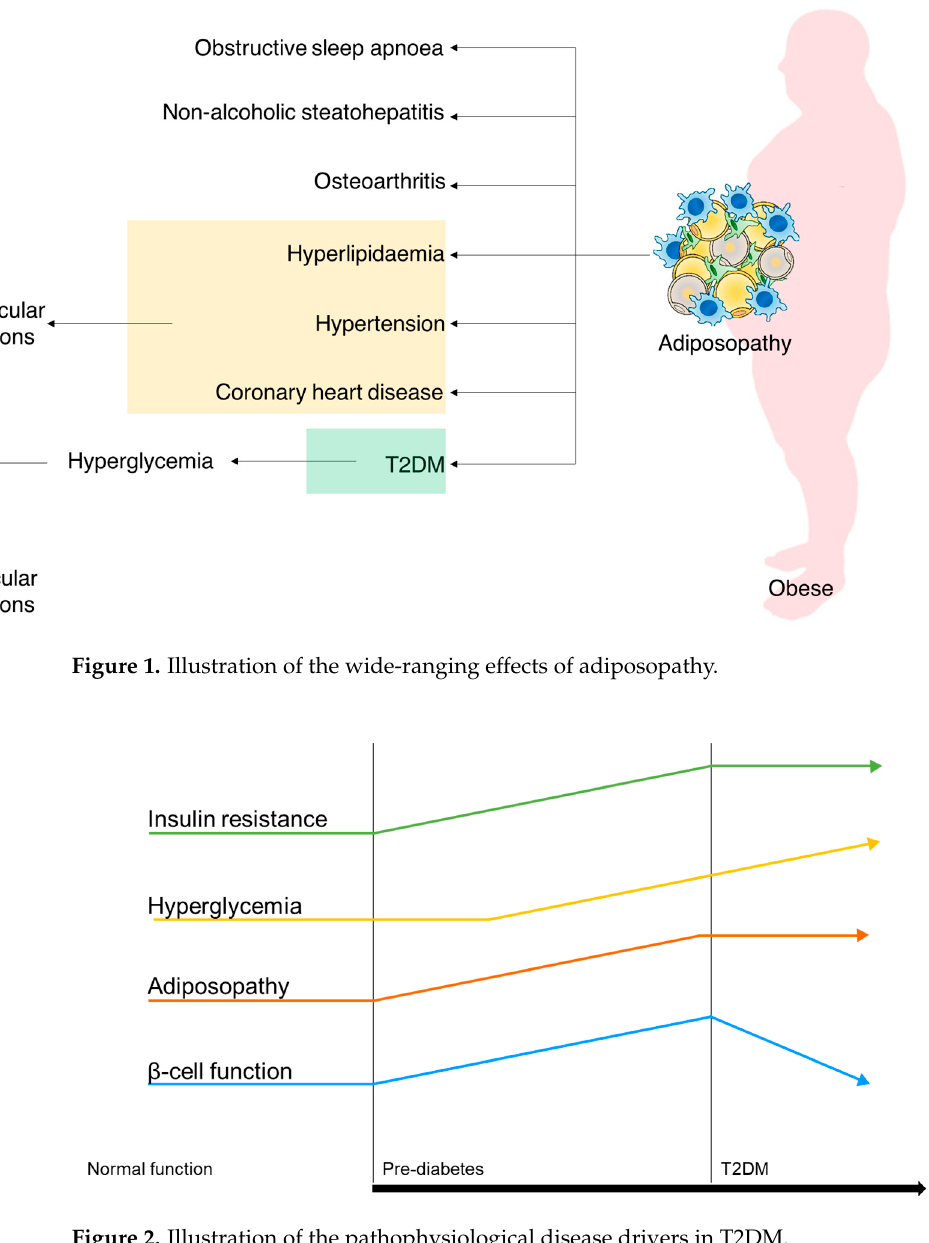
Figure 2. Illustration of the pathophysiological disease drivers in T2DM.